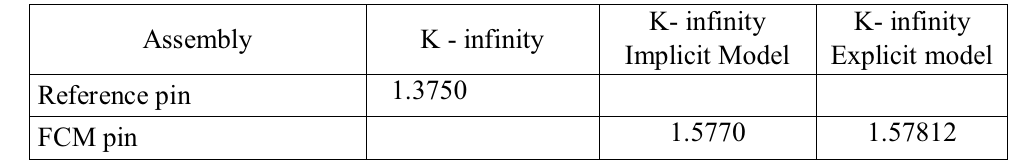
Table III. Single pin infinite multiplication